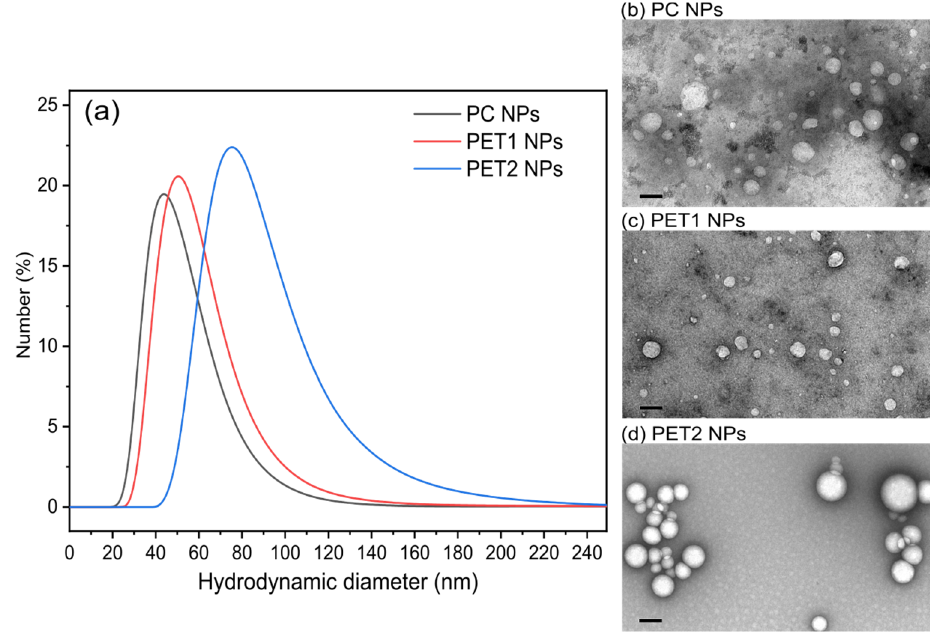
Figure 1. ( a ) Hydrodynamic diameter (D H ) distribution of PC NPs (black), PET1 NPs (red) and PET2 NPs (blue). Morphology of PC NPs ( b ), PET1 NPs ( c ) and PET2 NPs ( d ) by TEM. Scale bar: 100 nm.